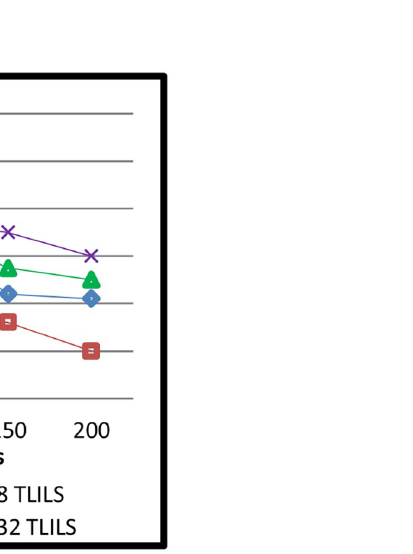
Fig 8. Packets delivery ratio of information dissemination with the TLILS with 10 m/s speed.